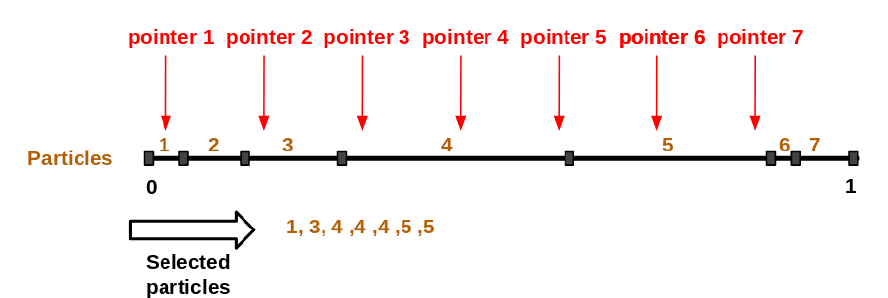
Figure 4. Principle of the stochastic universal sampling method in the case of 7 particles [54]. The brown numbers identify each i th particle and the segment size is proportional to its normalized weight W i